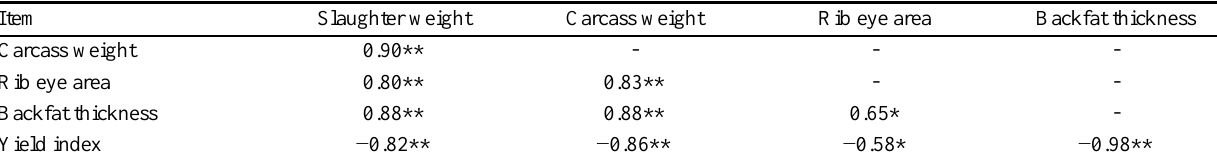
Table 9. Pearson’s correlation coefficients among carcass